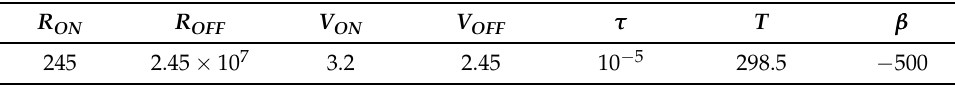
Table 1. The parameters of Au/Ni/HfO 2 /Ni RRAM